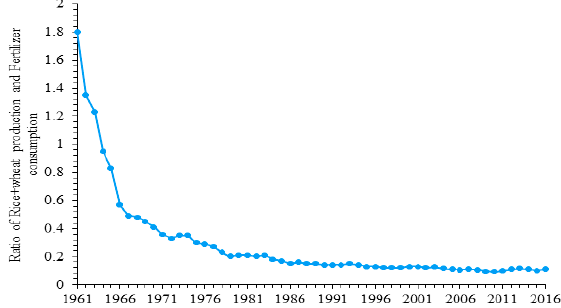
Figure 2. Ratio of rice + wheat production and fertilizer consumption during the period 1961–2016 on the Indian subcontinent, FAO (http://faostat.fao.org/).